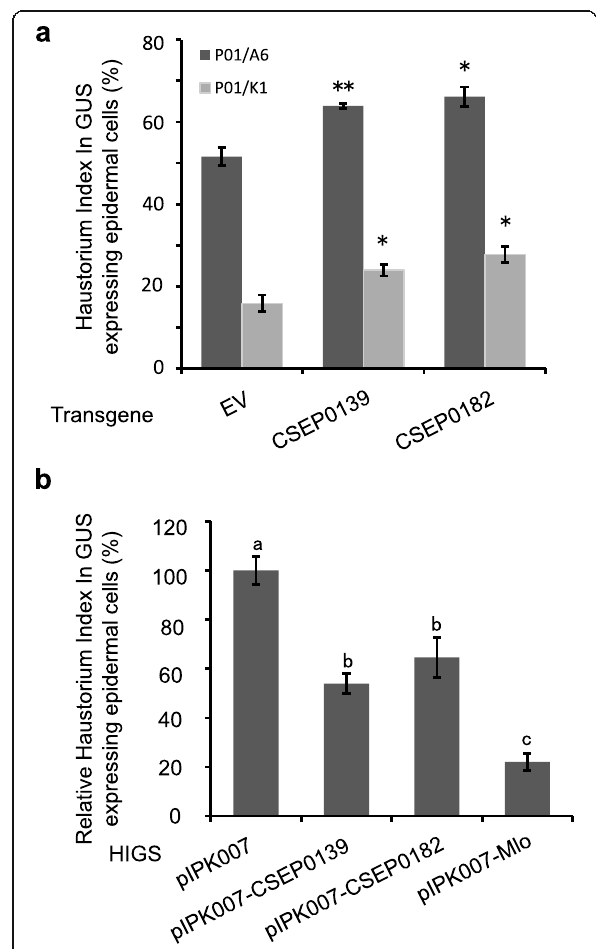
Fig. 5 CSEP0139 and CSEP0182 promote Bgh virulence in barley. a Overexpression of CSEP0139 and CSEP0182 increased Bgh haustorium formation in barley. One-week-old barley leaves (P01) were bombarded with GUS reporter along with pUBi-CSEP0139 or pUBi-CSEP0182 construct, respectively. Leaves were inoculated with spores of virulent isolate Bgh A6 or avirulent isolate Bgh K1 at 4 h after bombardment. Bgh haustorium index (%) was microscopically scored at 48 hpi. EV: empty vector. Error bar indicates SD, and similar experiments were repeated three times. The asterisk represents significant differences from EV at P < 0.01, determined by Student ’ s t test. b Silencing of CSEP0139 and CSEP0182 reduced Bgh haustorium formation in barley. The experimental setting was the same as in (a), with pIPK007 as the empty vector; HIGS constructs, pIPK007- CSEP0139 and pIPK007-CSEP0139, were constructed and used for silencing of CSEP0139 and CSEP0182 , respectively. Inoculation of virulent isolate Bgh A6 spores was carried out at 48 h after bombardment. Bgh haustorium index of each transformation was normalized to that of the empty vector pIPK007 (set to 100%). pIPK007-Mlo was used as a positive control. Data show the average values and SD, similar experiments were repeated three times. Means with different letters indicate significant difference ( P < 0.05). Duncan ’ s multiple range test was used to compare all the